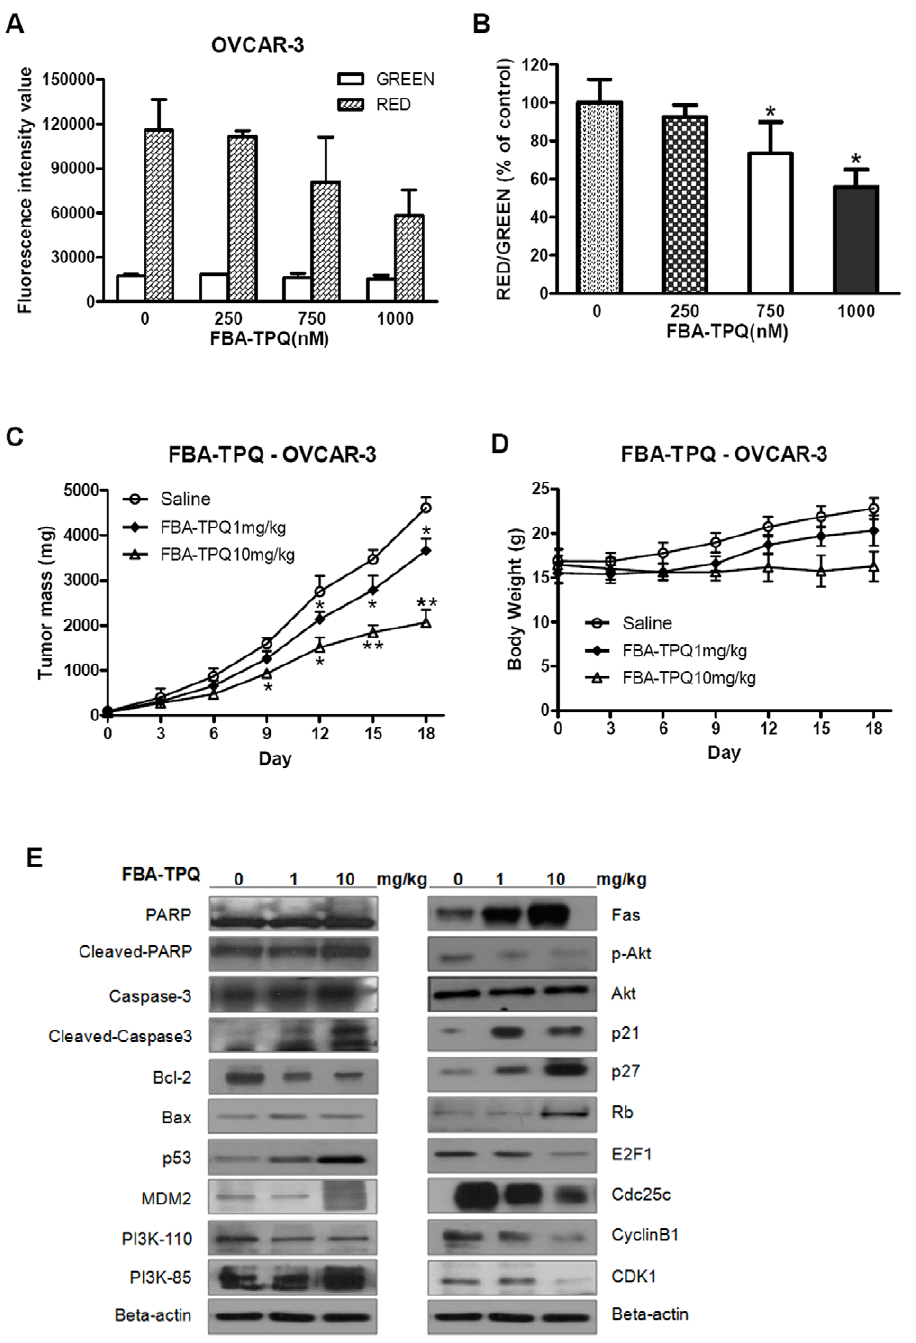
Figure 4. FBA-TPQ causes dissipation of the mitochondrial membrane potential and exerts potent tumor growth inhibition. A and B, Fluorescence intensity (JC-1 produces red fluorescence within the mitochondria as JC-1-aggregates while emits green fluorescence when leaks into the cytoplasm as JC-1-monomers; Fluorescence intensity shift between green and red is proportional to the DY m change) values of JC-1 dye at specific excitation wavelengths and the corresponding ratio of Red/Green change (% of the control) after exposure to FBA-TPQ for 24 h (*, p , 0.05 versus the control). C&D, Inhibition of tumor growth in mice bearing OVCAR-3 xenograft tumors (*, p , 0.05 versus the control; **, p , 0.01 versus the control), and the corresponding body weight changes during the treatments ( p . 0.05); E, Western-blot analysis of proteins (of the mice xenograft tumors after FBA-TPQ treatment of 0, 1 or 10 mg/kg dosage) involved in the FBA-TPQ-triggered, and PI3K-Akt mediated/p53-MDM2-related pathway. doi:10.1371/journal.pone.0020729.g004 tumors’ growth through the ROS/death receptor-initiated, and PI3K-Akt mediated/p53-MDM2-related cell proliferation and apoptosis and cell cycle progression-associated pathways (illustrat- ed in Fig. 5). However, the precise mechanism(s) of the compound,